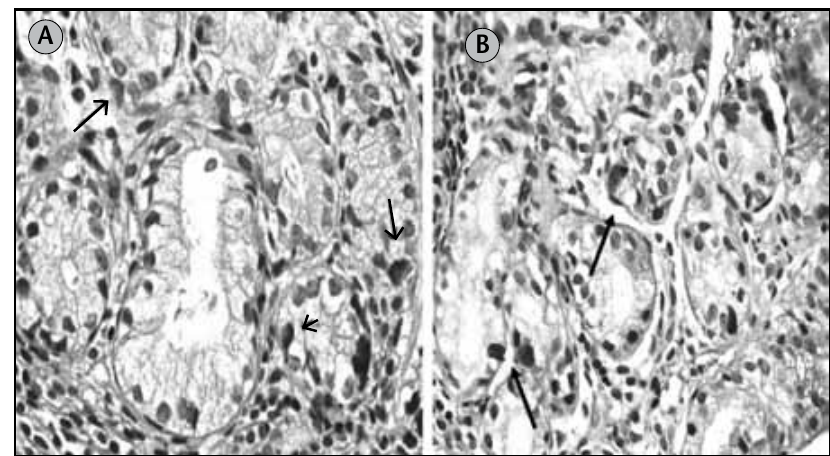
Figure 3 – Diffuse hyperplasic immunoreactive cells (arrows) to ghrelin (A) and to preproghrelin (B) in pseudopyloric metaplasia of gastric mucosa of patient with ABG (IHQ staining, 400×) ABG: atrophic body gastritis; IHQ: